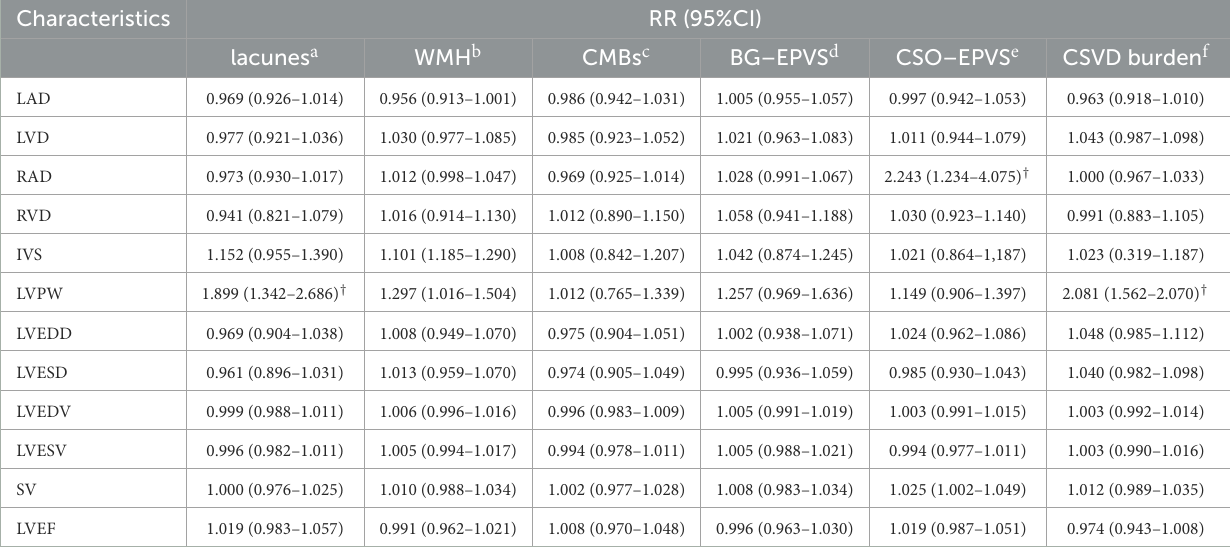
TABLE 4 Multivariate analysis for association of echocardiographic parameters with MRI markers of CSVD.